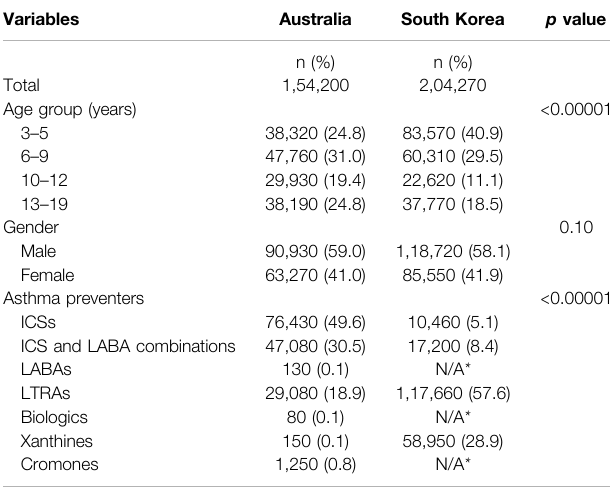
TABLE 2 | Baseline characteristics of paediatric asthma preventer users in Australia and South Korea,